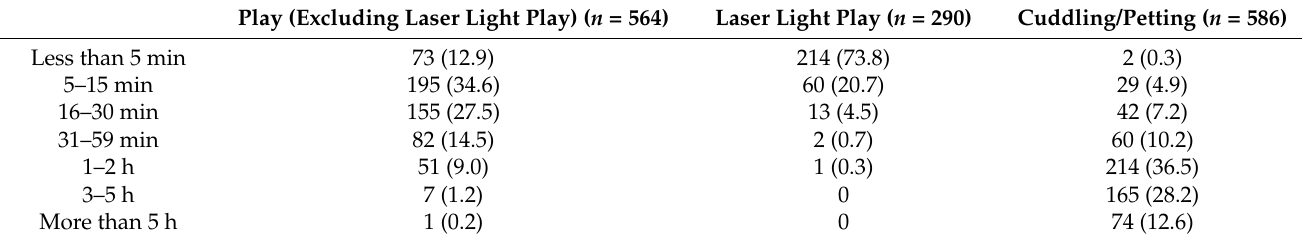
Figure 5. Reasons given by cat guardians for using laser light pointers to play with their cats ( n = 282). When guardians were asked to report the total amount of time they spent over the span of a day engaged in LLP play, other forms of play and cuddling/petting, they re- ported spending the least amount of time each day engaged in LLP play (Table 2). When most bonded after cuddling, followed by play without laser, and then LLP play (Table 3). Table 2. Total amount of time spent over the span of an entire day in cat related activities. Play (Excluding Laser Light Play) ( n =